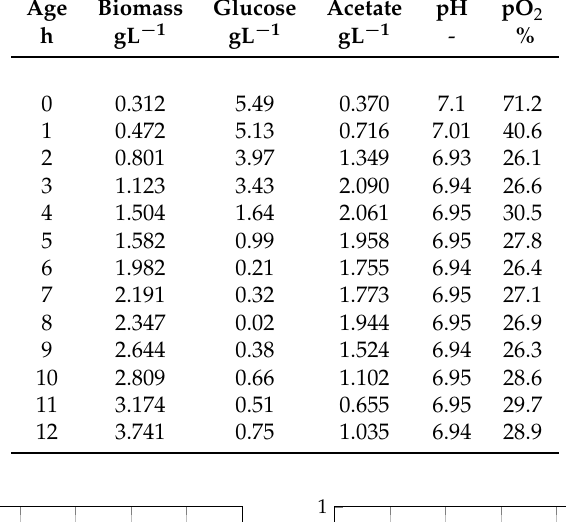
Table 11. Experiment 2: State variables and operating conditions during the culture.